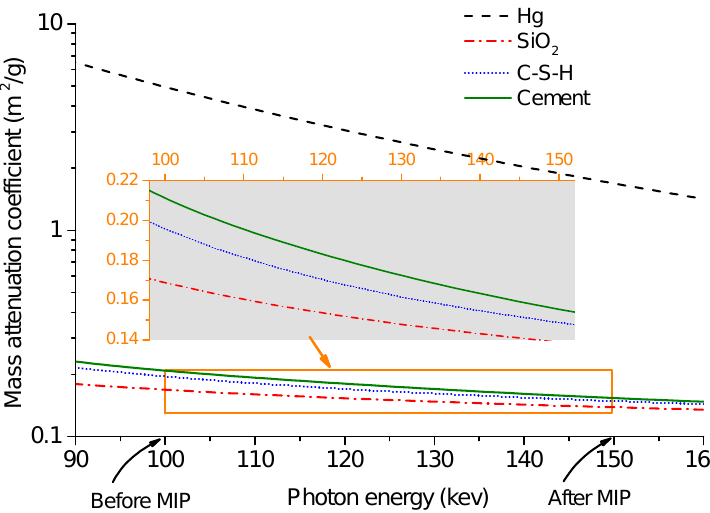
Figure 2. Spectra of mass attenuation coefficient of Hg, SiO 2 , C-S-H and cement between 90 KeV and 160 KeV (Data from Ref. [31] ).